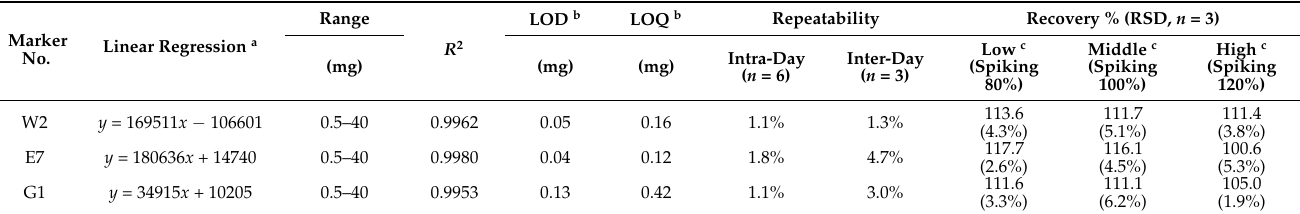
Table 3. Validation of the established quantitative method.